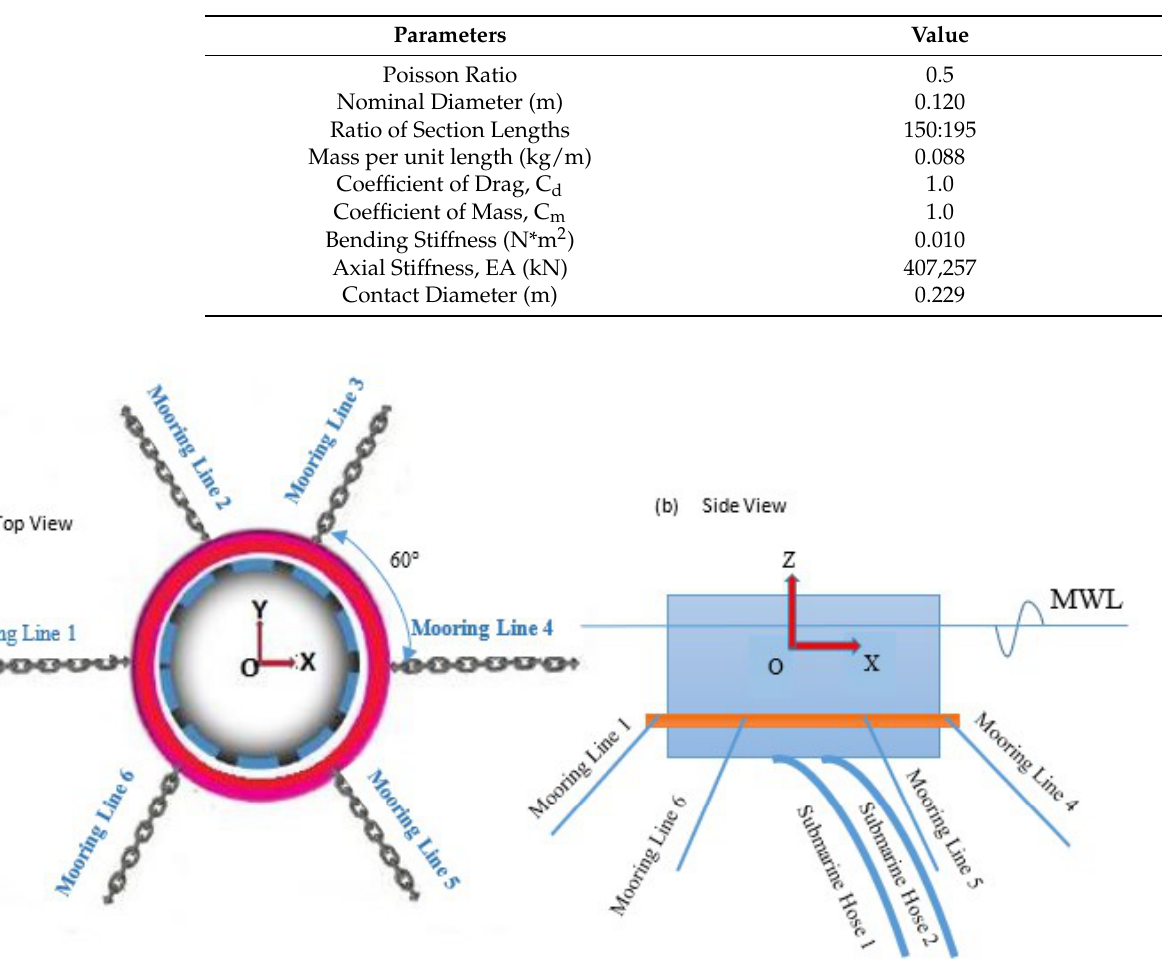
Figure 9. Typical floats attached to offshore submarine hoses .